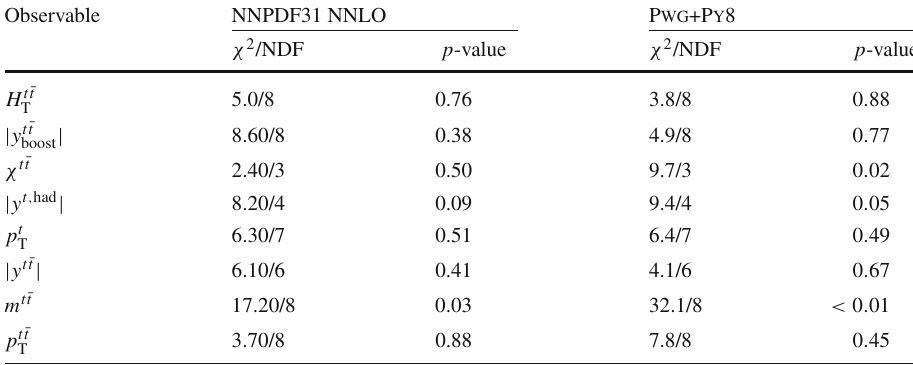
cross-section to the NNLO prediction and the prediction obtained with the Powheg + Pythia8 MC generator. The hatched band represents the total uncertainty in the NNLO prediction. The solid bands represent the statistical and total uncertainty in the data